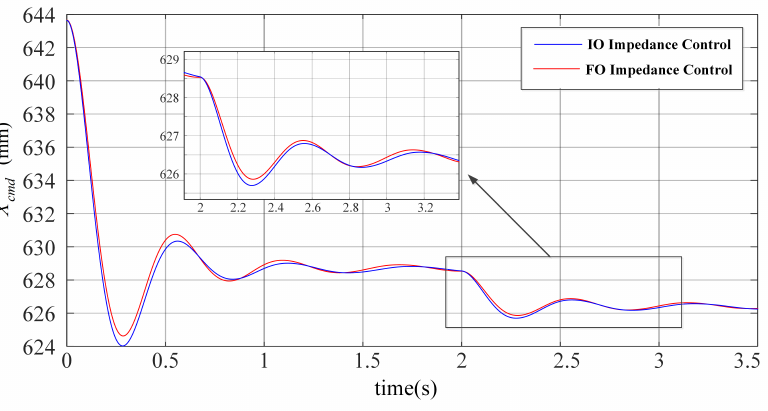
Figure 15. Control signal comparison of FO/IO-impedance controller in